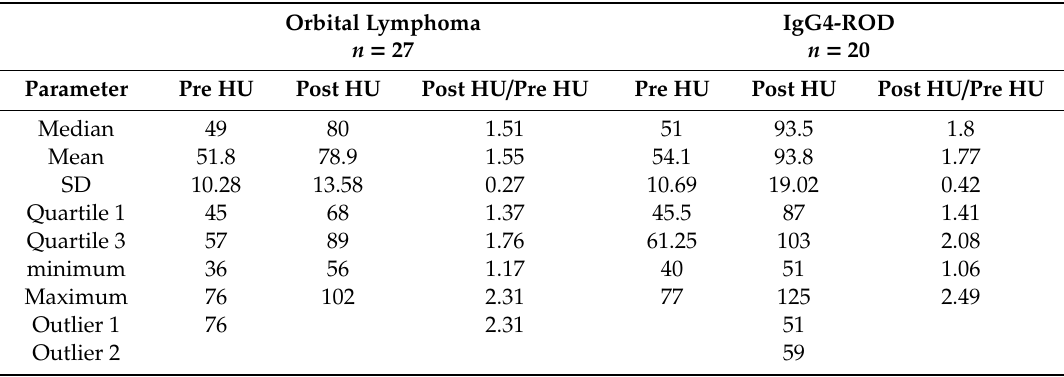
Table 3. Descriptive statistical prebiopsy values of precontrast CT Hounsfield unit scales (Pre HU), postcontrast CTHU (Post HU) and postcontrast CTHU / precontrast CTHU ratios (Post HU / Pre HU) of 27 tumors of orbital lymphoma and 20 tumors of IgG4-related orbital disease (IgG4-ROD) on prebiopsy orbital CT scans.